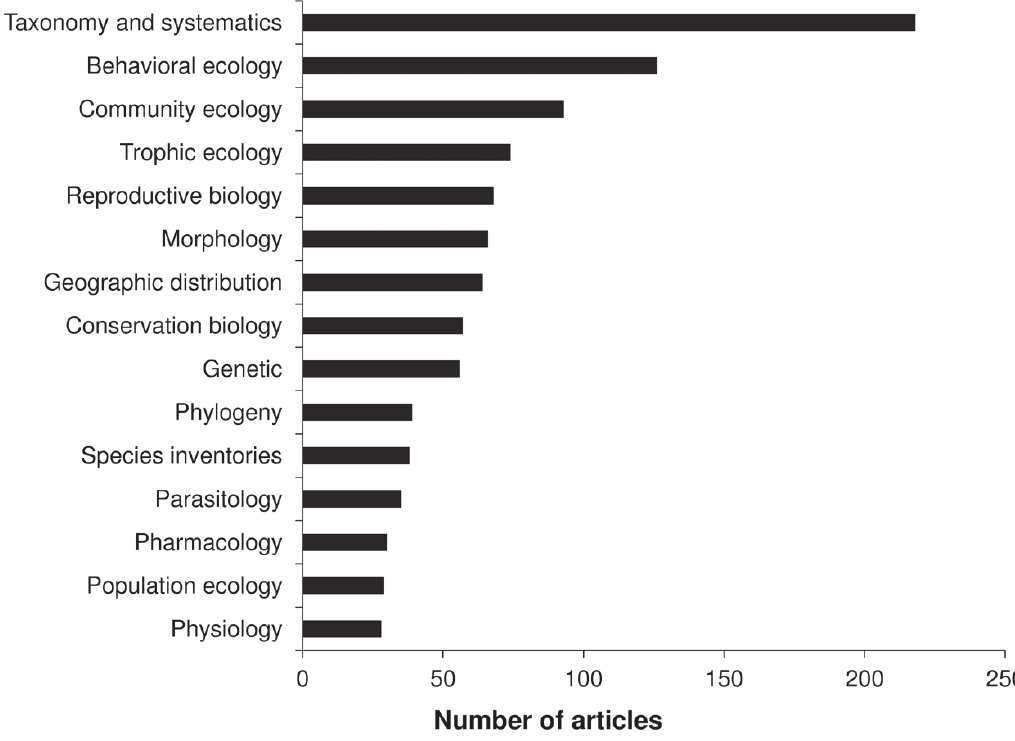
Figure 6 - Total number of articles published between 2001 and 2010 on amphibians from Brazil (N = 892) according to their respective research